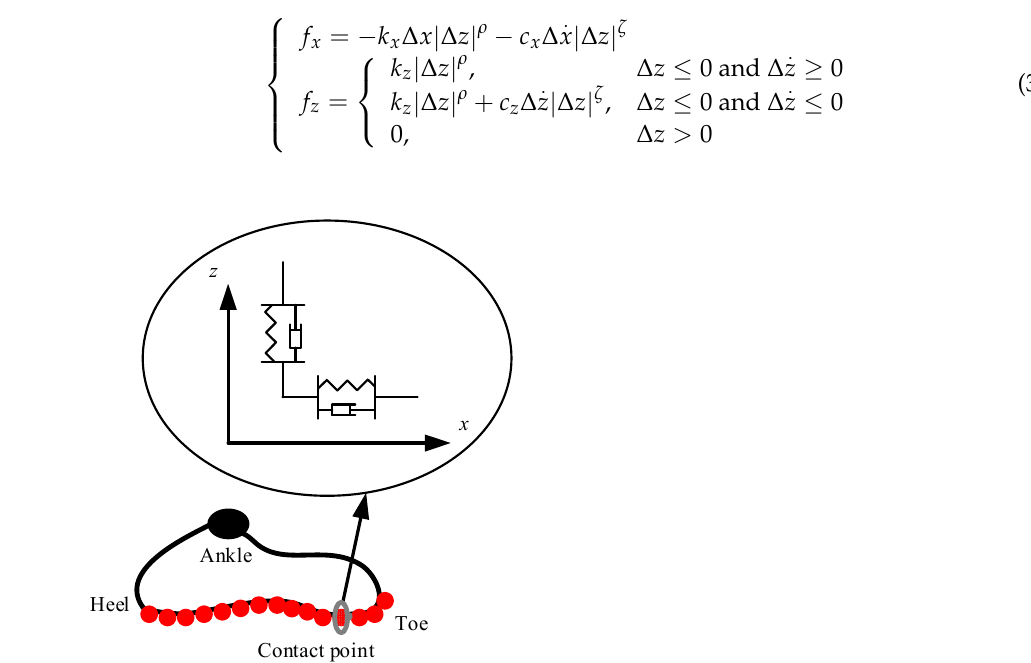
Table 2. Main parameters of the contact model.